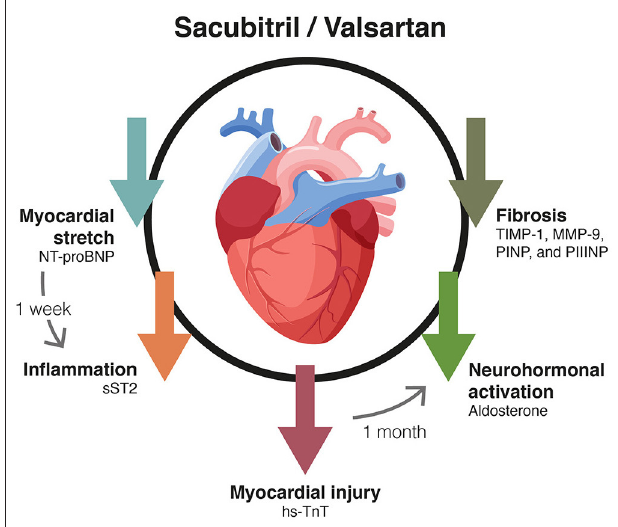
FIGURE 5 | Effect of the treatment with sacubitril/valsartan on HF biomarkers. Nt-proBNP, N-terminal pro b-type natriuretic peptide; sST2, soluble tumorigenicity suppressor 2; hs-TnT, high-sensitivity troponin T; TIMP-1, metallopeptidase inhibitor 1; MMP-9, matrix metallopeptidase 9; PINP, aminoterminal propeptide of type I collagen; PIIINP, N-terminal propeptide of procollagen type